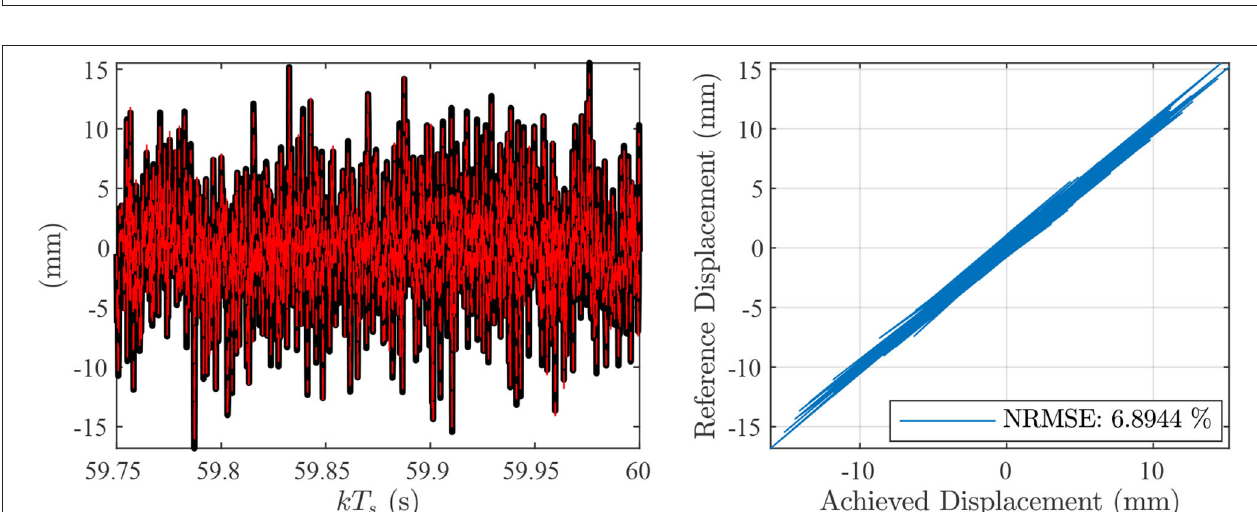
FIGURE 8 | Forward (Top) and inverse (Bottom) absolute adaptation errors for the filters of Figure 7 .